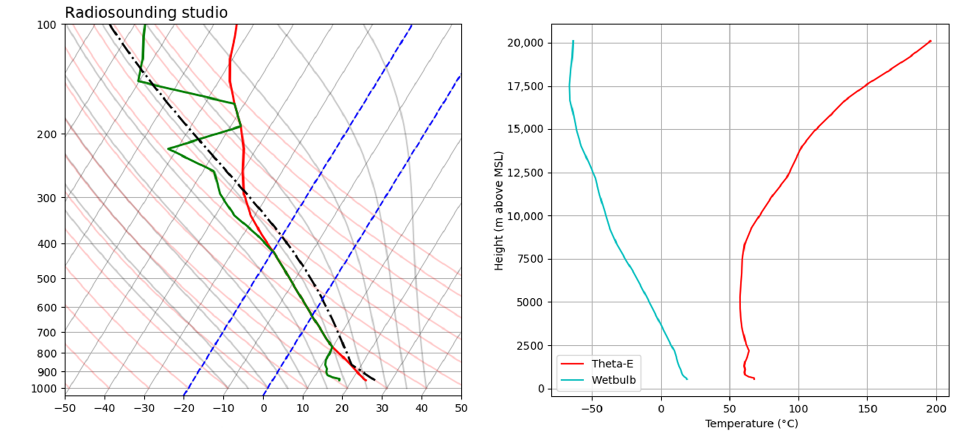
Figure 27. Radiosounding profile ( left ), theta-E and wetbulb profile ( right ), obtained with data from WRF 1 km.